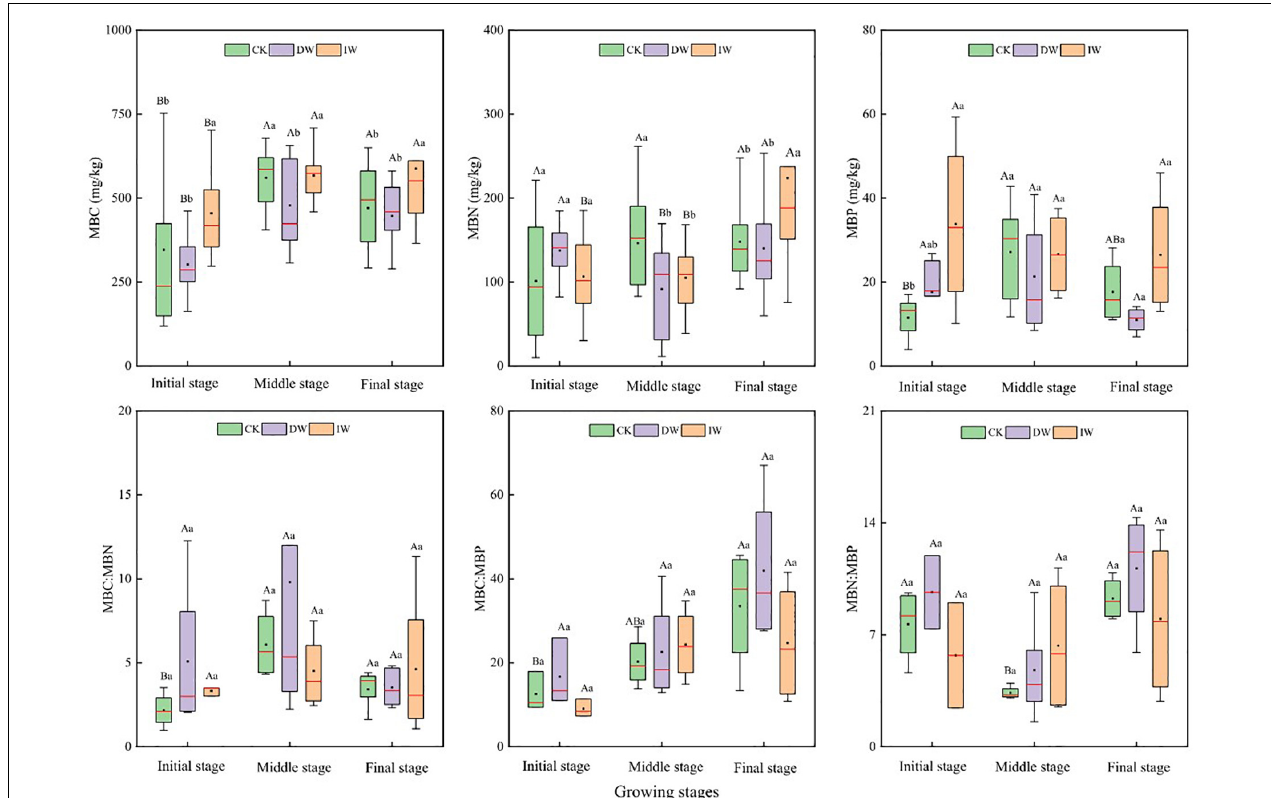
FIGURE 5 | Response of soil microbial biomass C, N, P ecological stoichiometry characteristics to precipitation manipulation at different growth stages. CK, ambient precipitation; DP, decrease precipitation (–50%); IP, increase precipitation (+50%); MBC, microbial biomass carbon; MBN, microbial biomass nitrogen; MBP, microbial biomass phosphorus; MBC:MBN, MBC:MBN ratio; MBC:MBP, MBC:MBP ratio; MBN:MBP, MBN:MBP ratio. Different small letters mean significant difference among different treatments at the 0.05 level; different capital letters mean significant difference among different growing stages at the 0.05